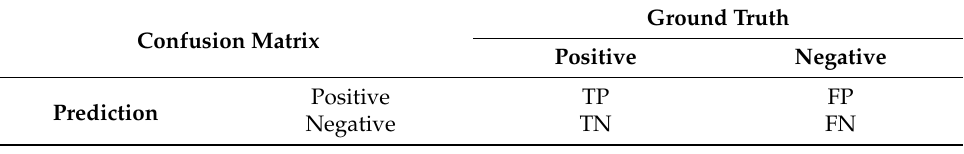
Table 12. Confusion matrix for binary classification.